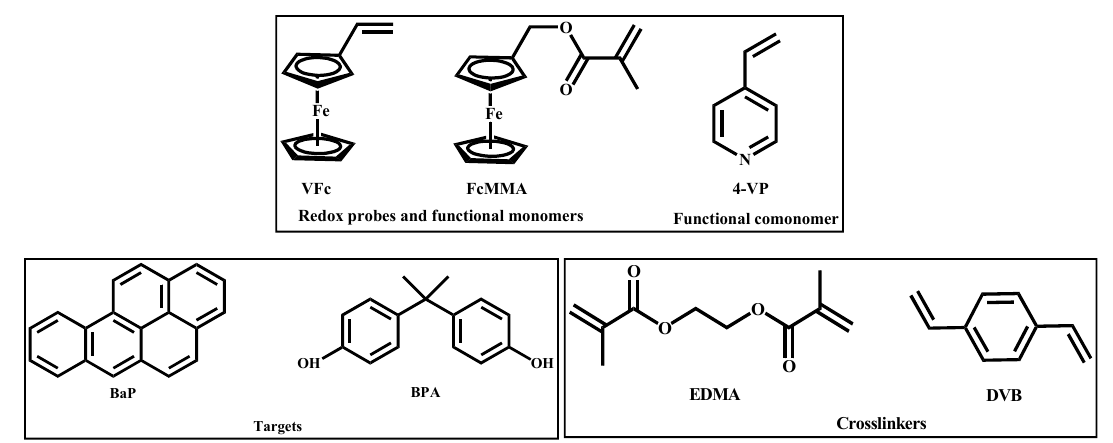
Figure 1. Molecular structures of e-MIP components.